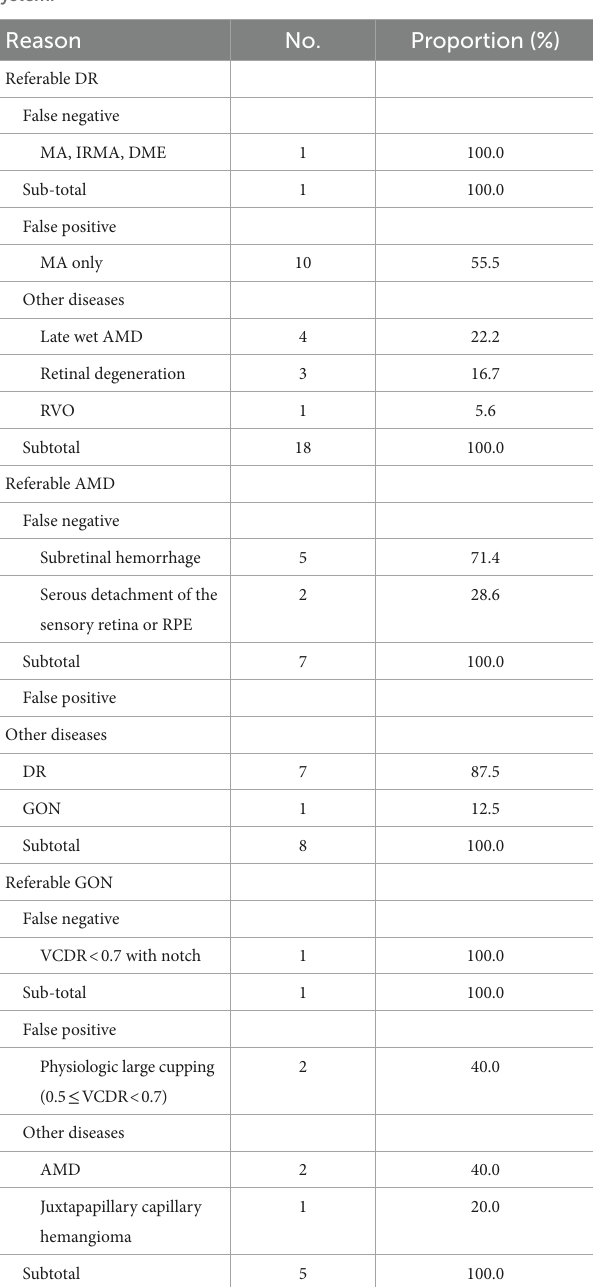
TABLE 5 Characteristics of the disagreement images by human participants. a